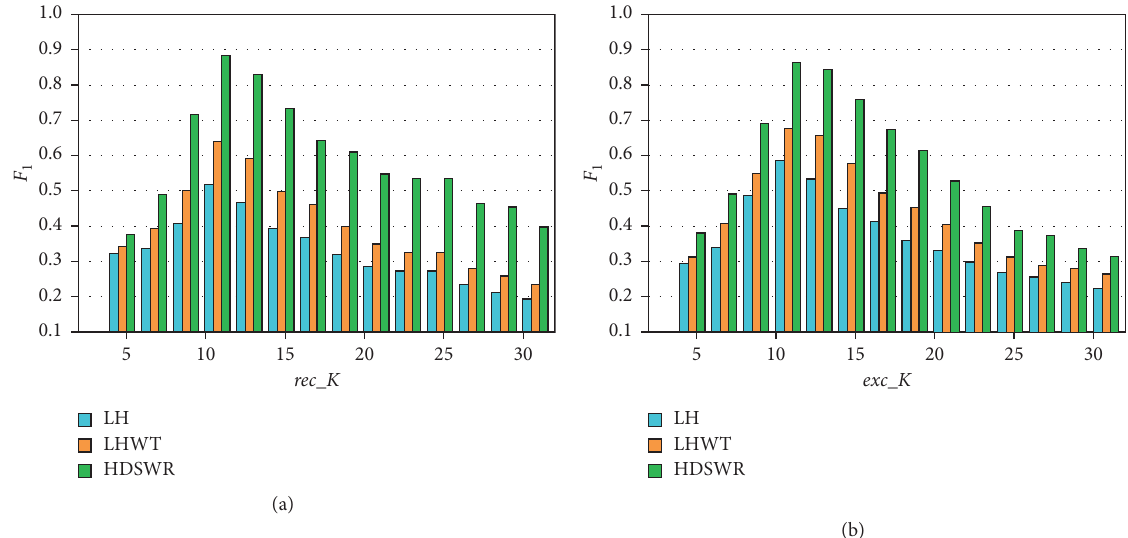
Figure 6: Efficiency comparison of different recommendation methods on the dataset